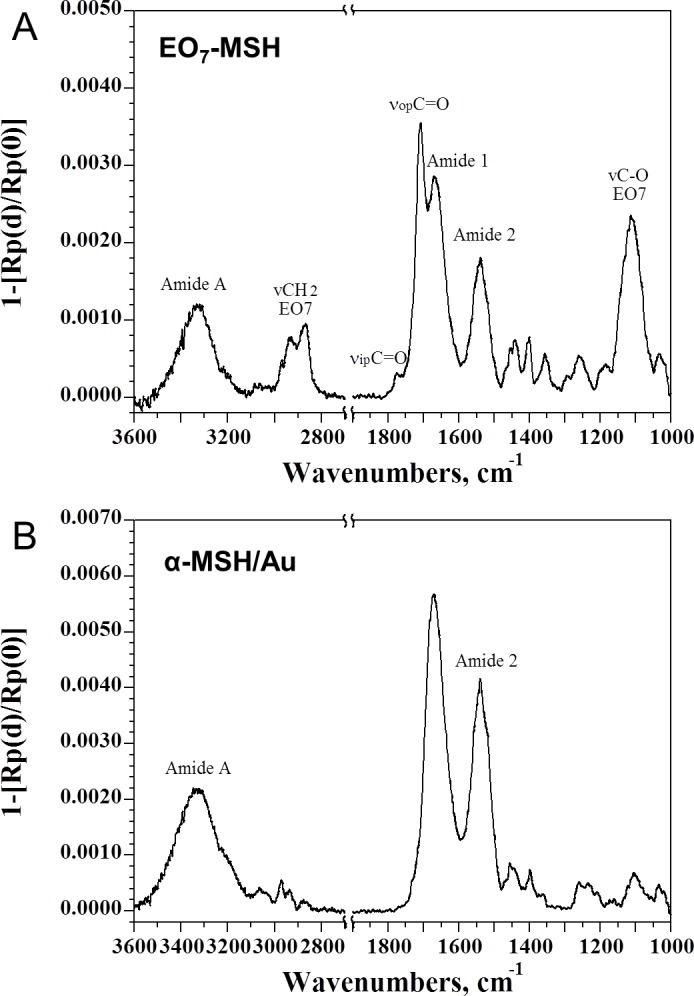
PM-IRRAS analysis.Spectra, expressed in IRRAS units, of (A) EO7-MSH surface and (B) compact monolayer of α-MSH.